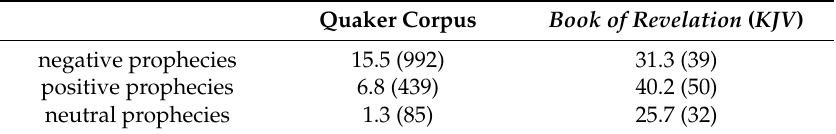
Table 2. Comparison by frequency of context-based prophecy-connotations: Quaker corpus and the Book of Revelation , KJV .